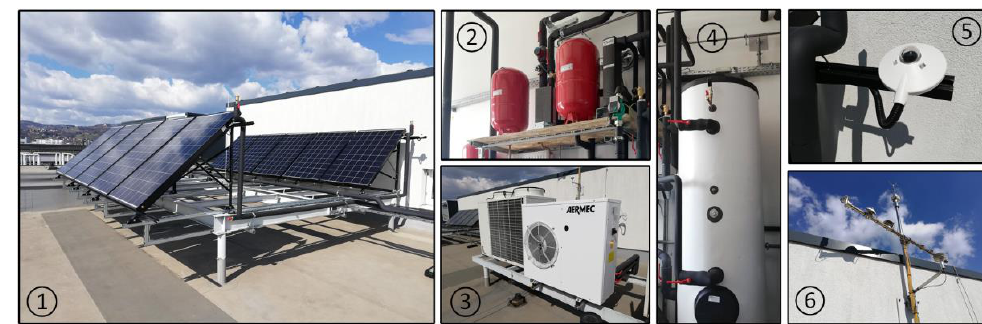
Figure 1. Functional scheme of the photovoltaic/thermal system.